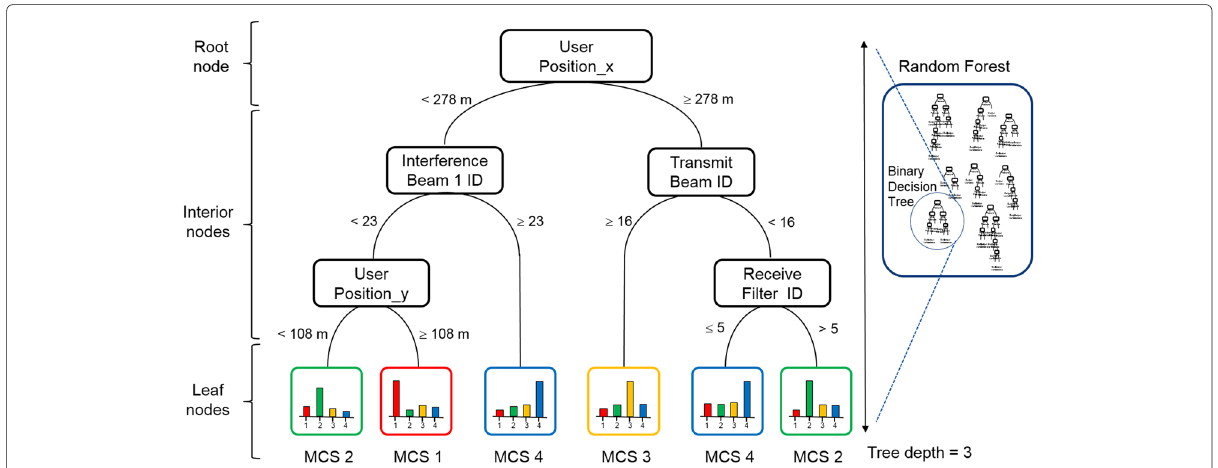
Fig. 3 An example of a binary random decision